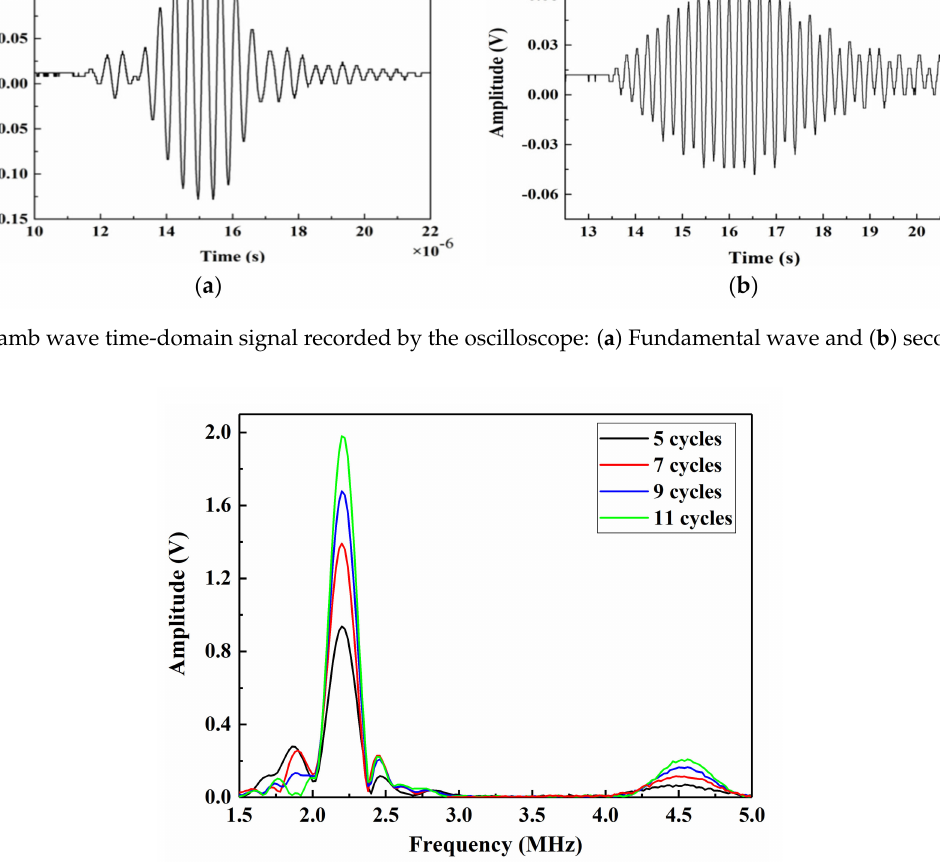
Figure 4. Frequency-domain signal during various